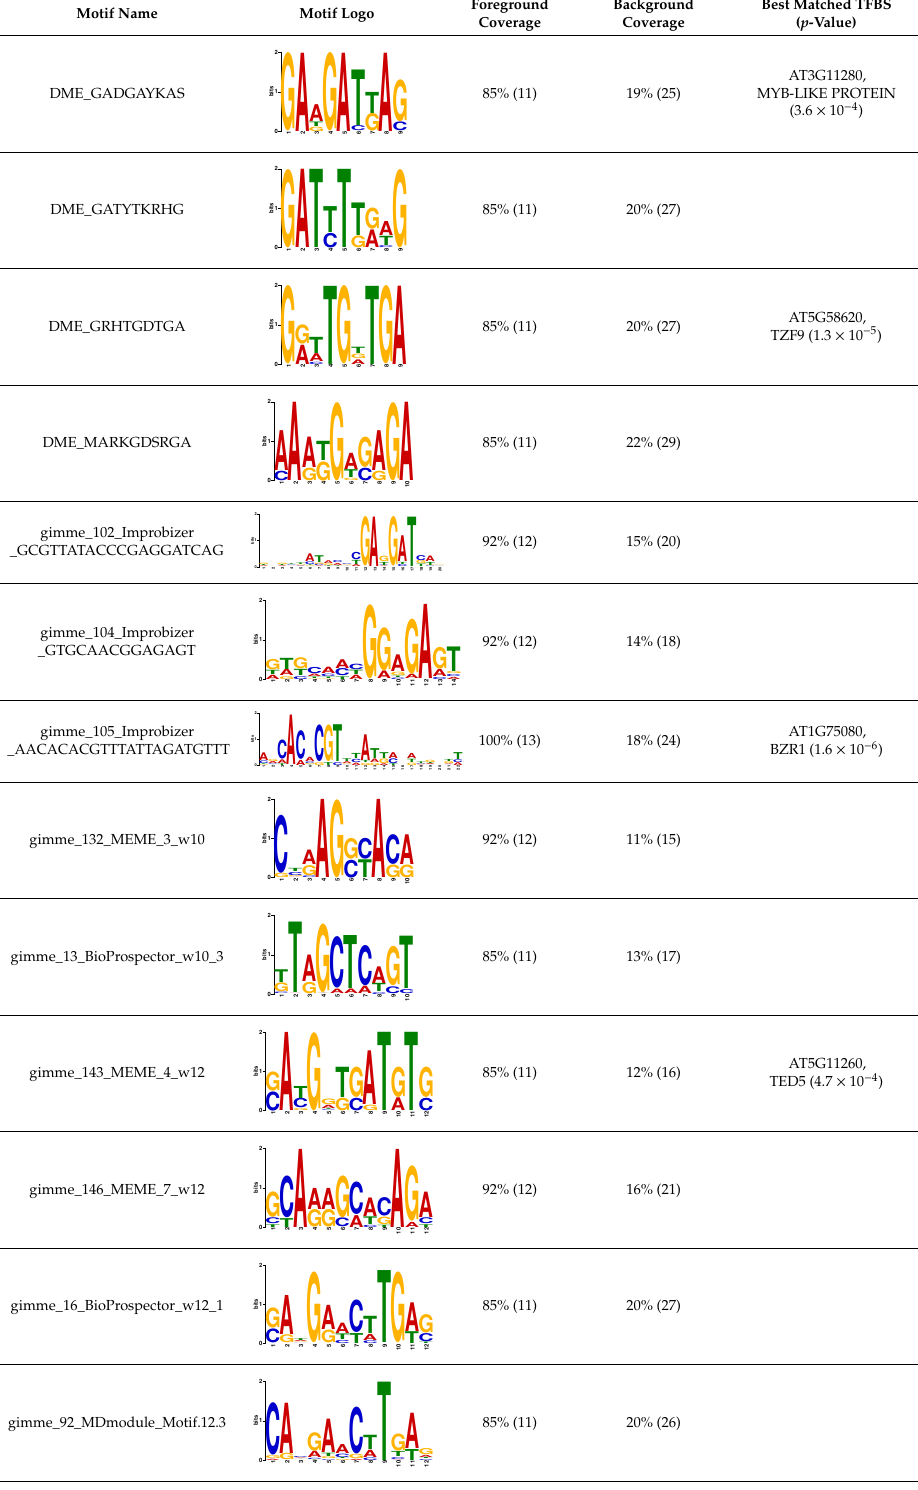
Table 2. Motifs identified by Filter A. The foreground coverage indicates the percentage (and number) of pollen-specific HRGP genes having an identified motif in its promoter region. The background coverage is the percentage (and number) of the non-pollen HRGP genes having that motif in its promoter region. The relative frequency is the foreground coverage divided by the background coverage. The matched transcription factor binding sites (TFBS) p -value is a known transcription factor binding site that relates to pollen along with the accompanying p